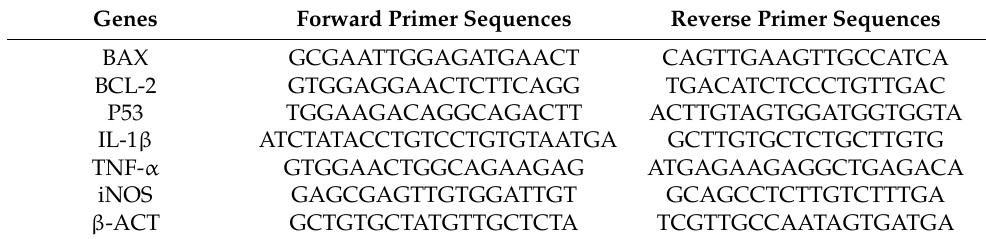
Table 2. Oligonucleotide primers used for the quantitative real-time PCR analyses. Genes Forward Primer Sequences Reverse Primer Sequences